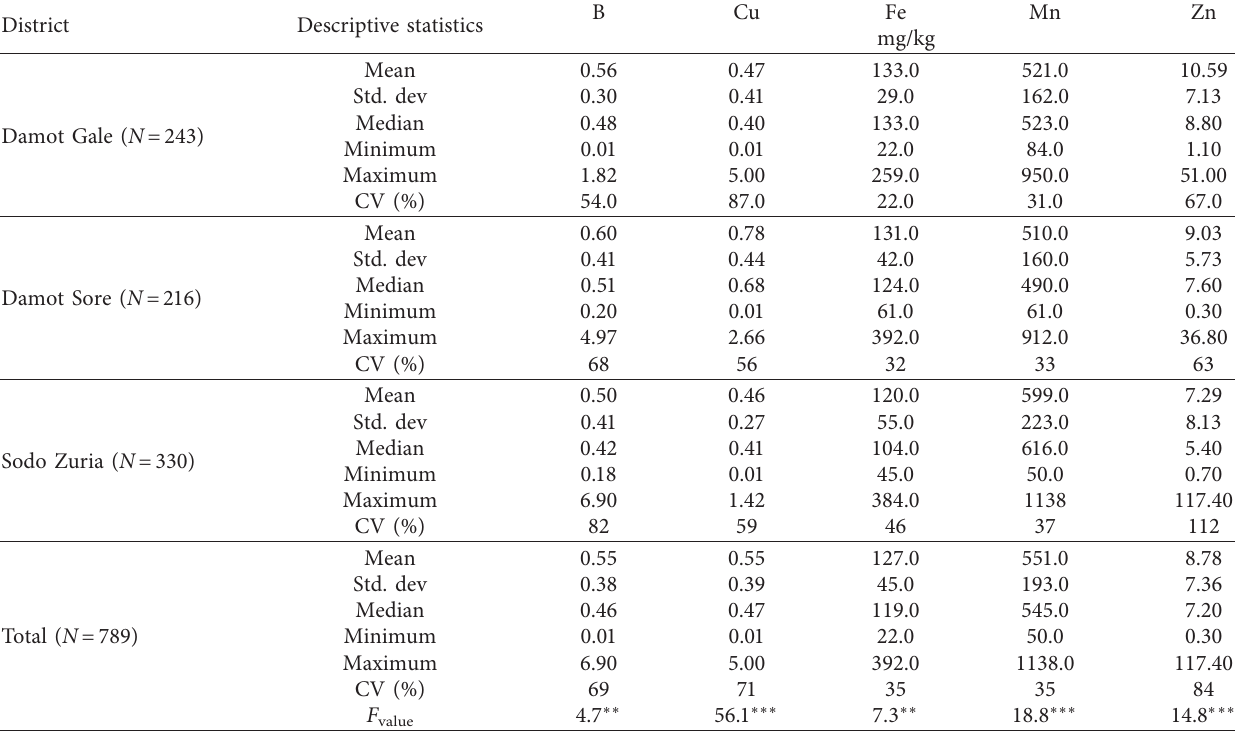
Table 7: Descriptive statistics of soil micronutrients (B Cu, Fe, Mn, and Zn) for surface soils. District Descriptive